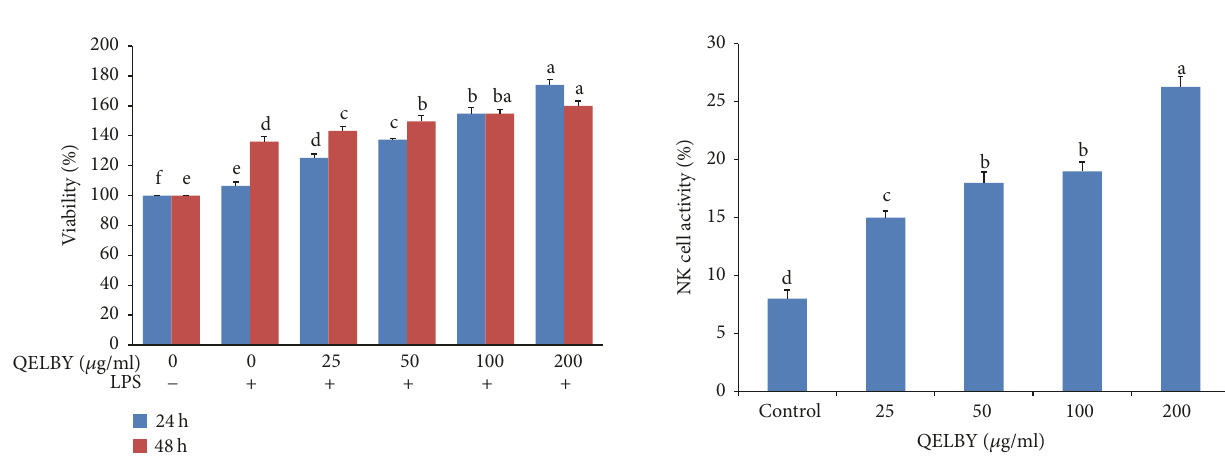
Figure 8: Evaluation of the viability of RAW 264.7 macrophage cell. Culture media were prepared by mixing with different amount of suspended layer from the DMEM mixed with 1% of QELBY ceramic powder and left for 48 hours. The blue and red bars indicate the length of incubating time, 24 hours and 48 hours, respectively, with the prepared media. Data are mean ± SD (𝑛 = 4) . Bars with different superscript for each standing time are significantly different at 𝑝 < 0.05